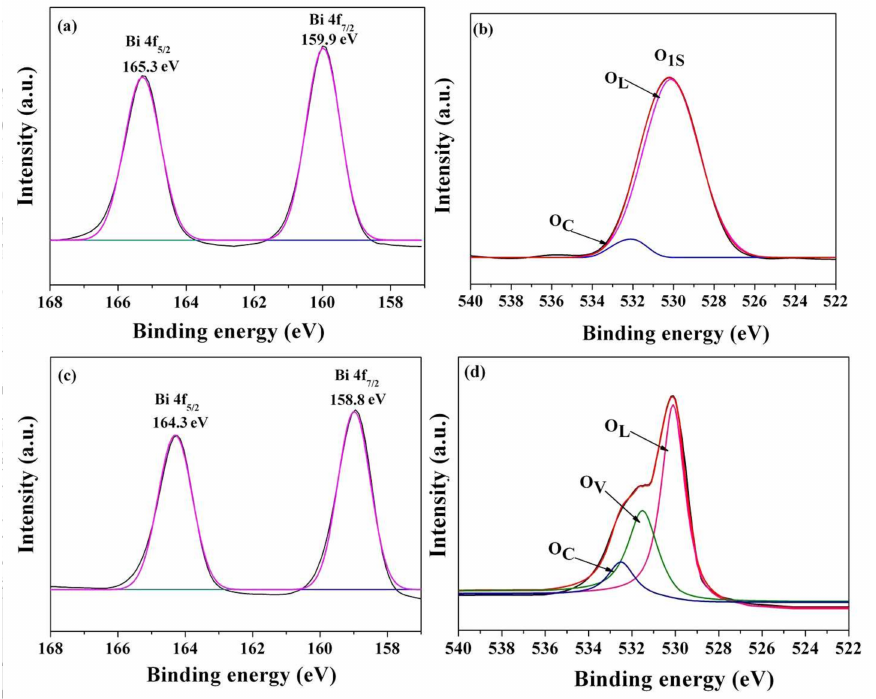
Figure 7. High-resolution X-ray photoelectron spectrometer (XPS) spectra: ( a ) Bi 4f and ( b ) O1s of the pristine Bi 4 Ti 3 O 12 ; ( c ) Bi 4f and ( d ) O1s of Bi 4 Ti 3 O 12 − x (350 ◦ C, 60